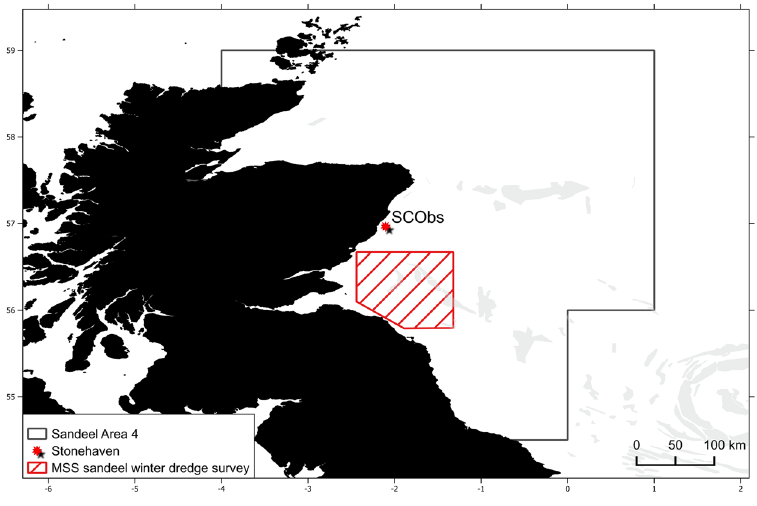
Figure 6. Study Area. Boundary of sandeel management area 4 is indicated by a solid black line, the location of MSS sandeel winter dredge surveys by red shading and the Scottish Coastal Observatory (SCObs) station of Stonehaven by a red